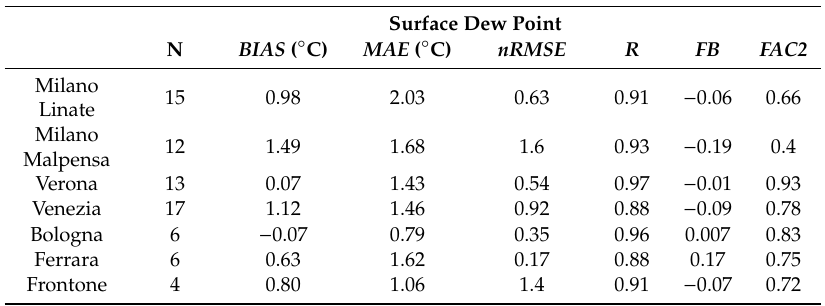
Table3. StatisticalscoresofWRFsurfacedewpointoutputsrelatedtothesevenselectedsitesmeasurements. (A negative BIAS means a WRF underestimation and vice